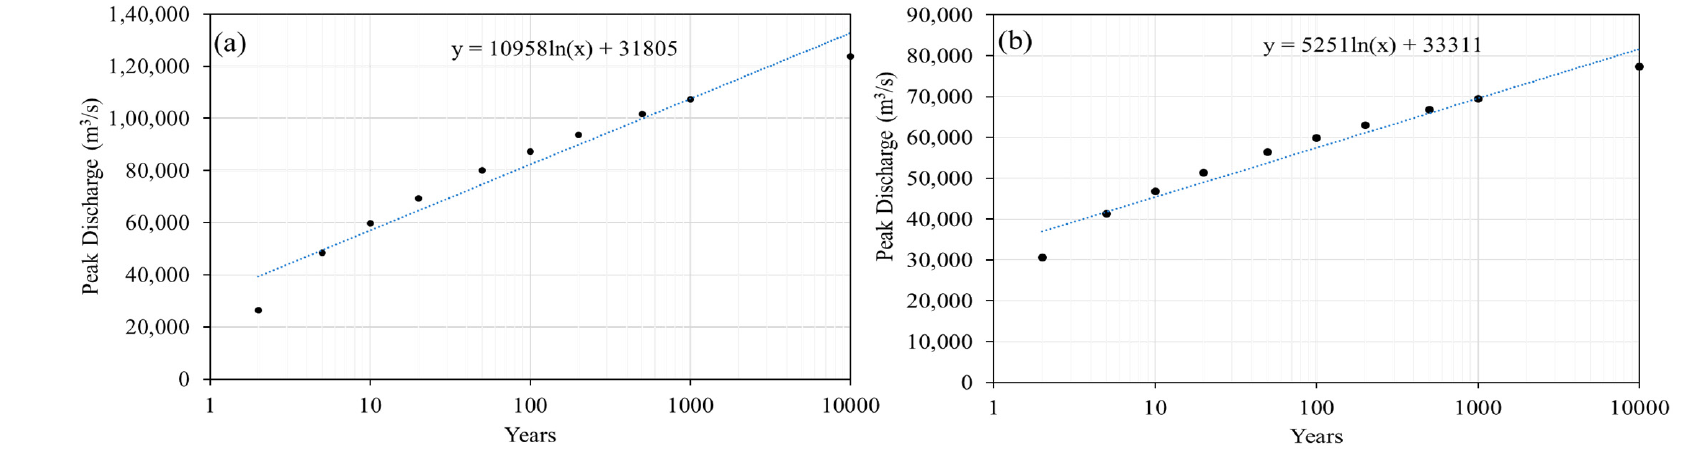
Figure 8. Discharges at ( a ) Dowleswaram and ( b ) Polavaram obtained using normal distributions.